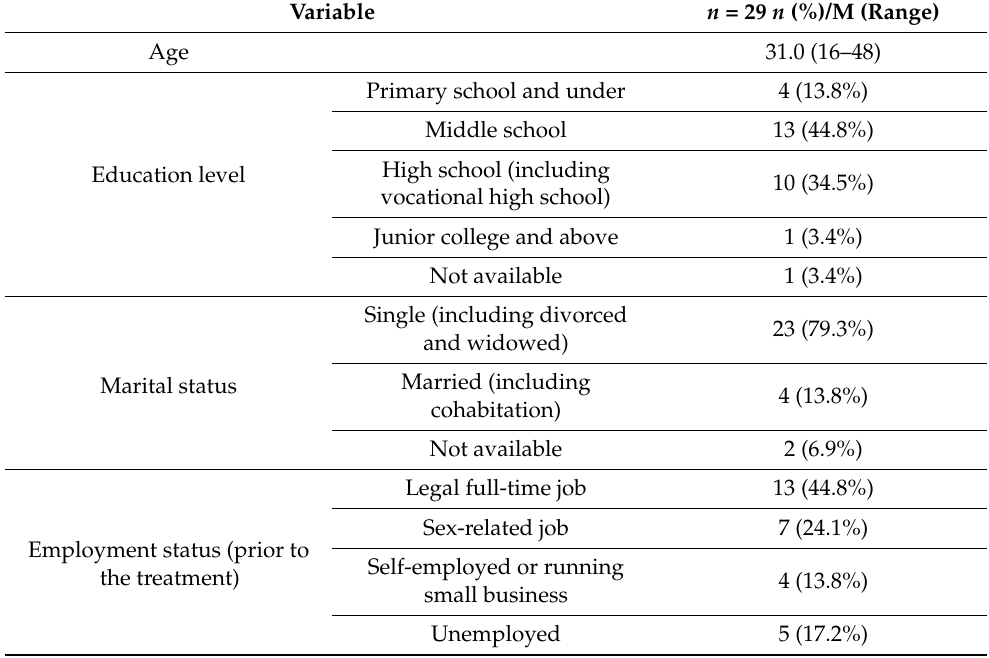
Table 1. Key demographic variables of 29